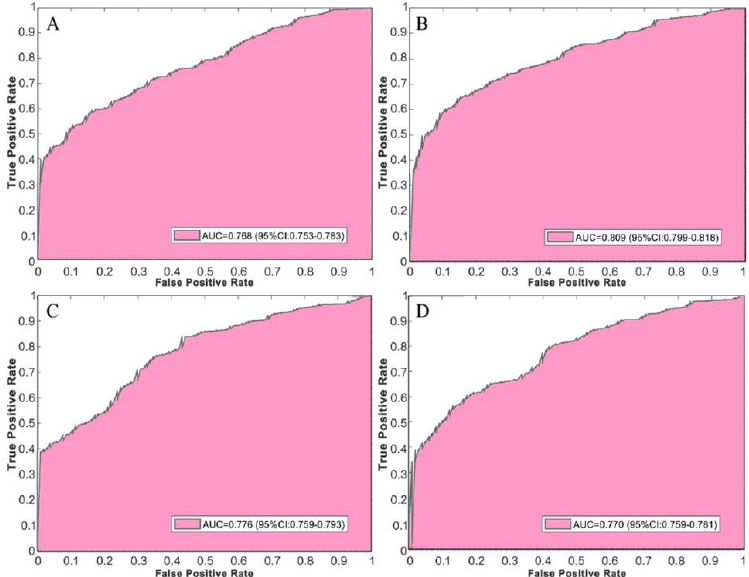
Figure 5. ROC curves of IGRNet using various activation functions: ( A ) is the ROC curve of the model using the ReLU function, ( B ) is the ROC curve of the model using the LeakyReLU function, ( C ) is the ROC curve of the model using the ELU function, and ( D ) is the ROC curve of the model using the ClippedReLU